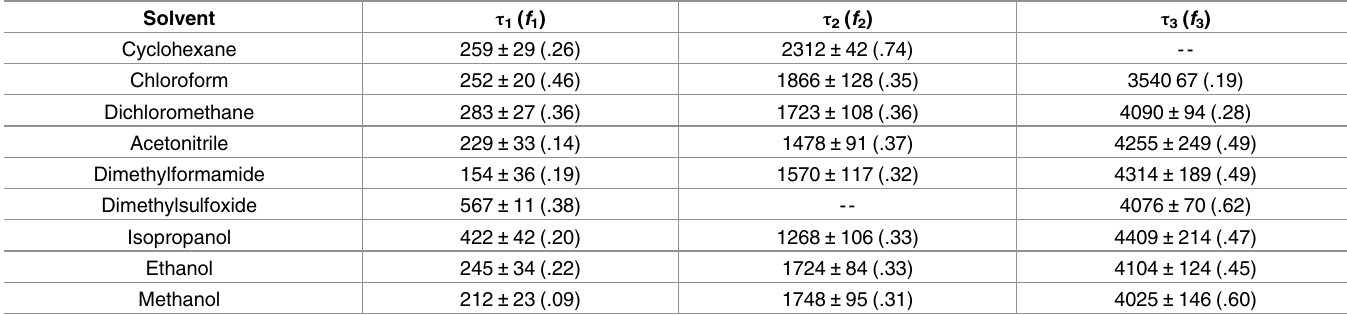
Table 6. Fluorescence decay of the K2T23 diketo conformers.